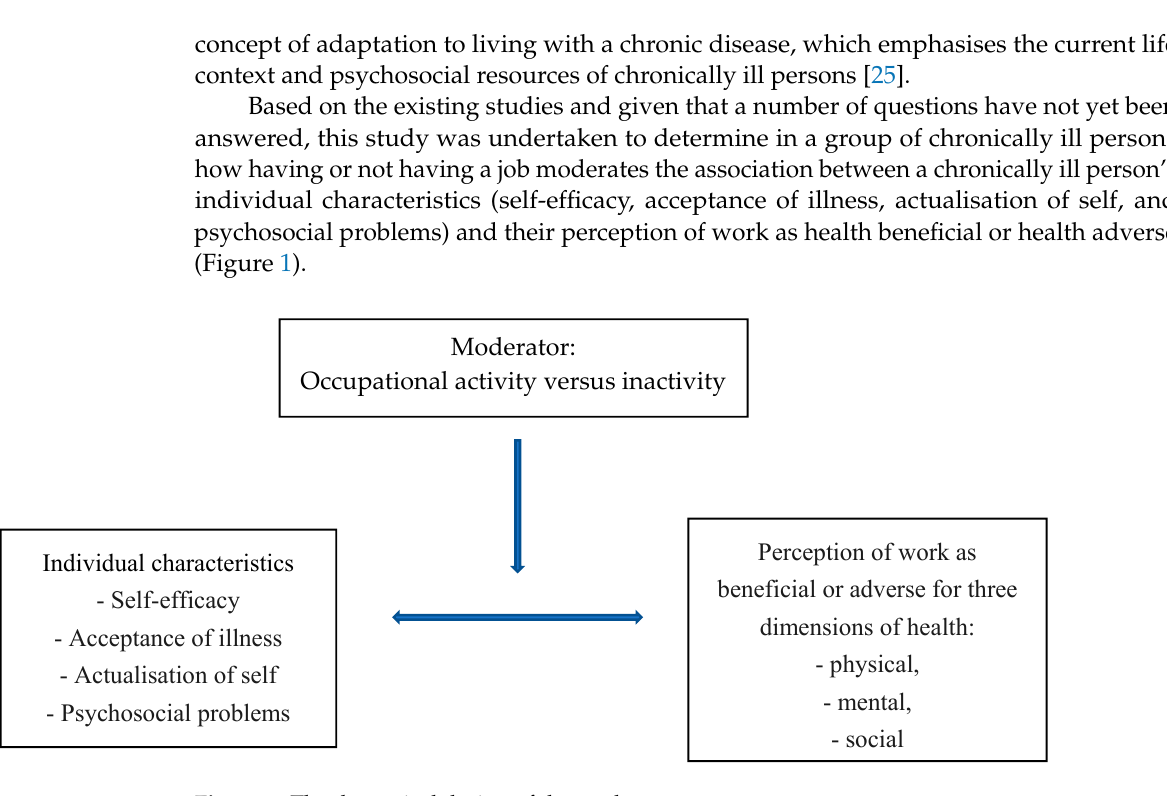
Figure 1. The theoretical design of the